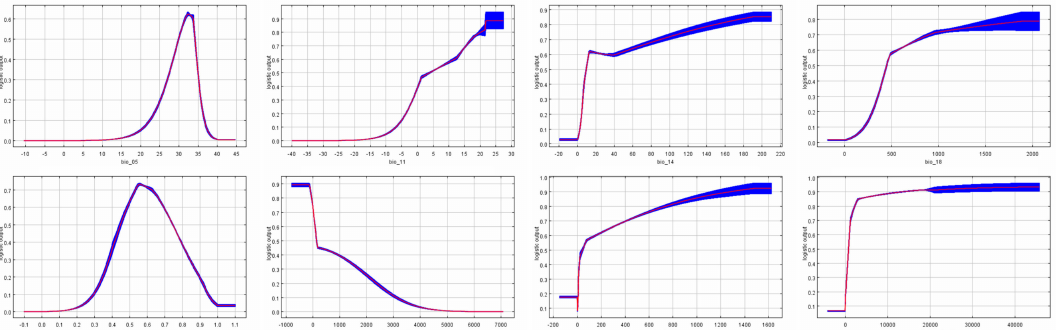
Figure 6. Response curves for representative